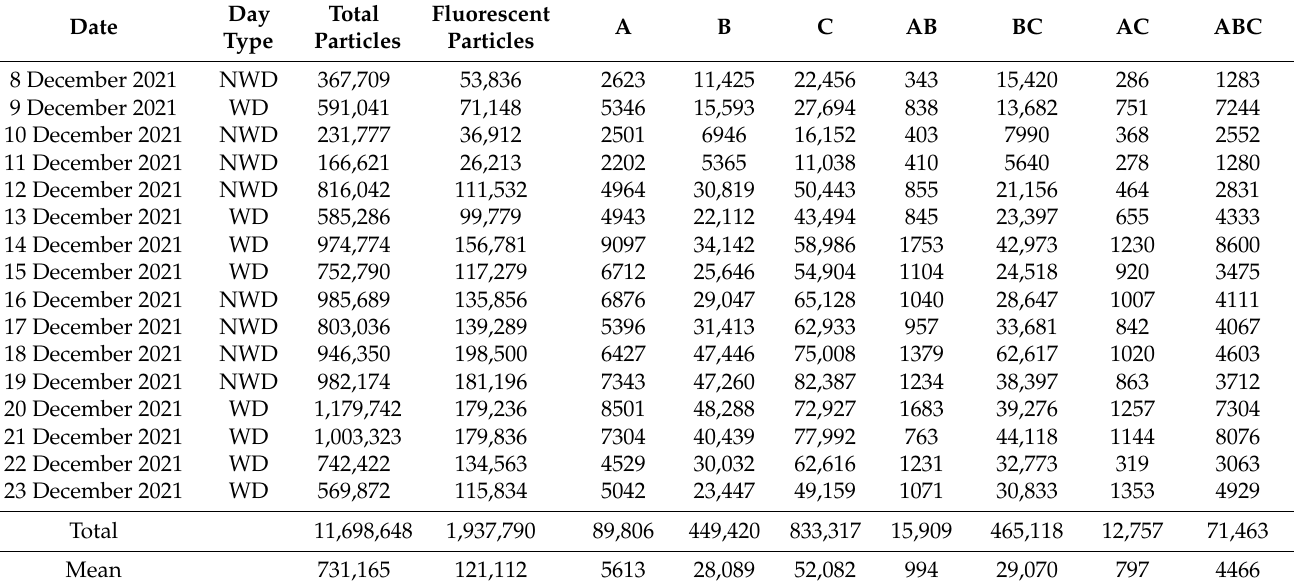
Table 1. Number of particles sampled in each day.